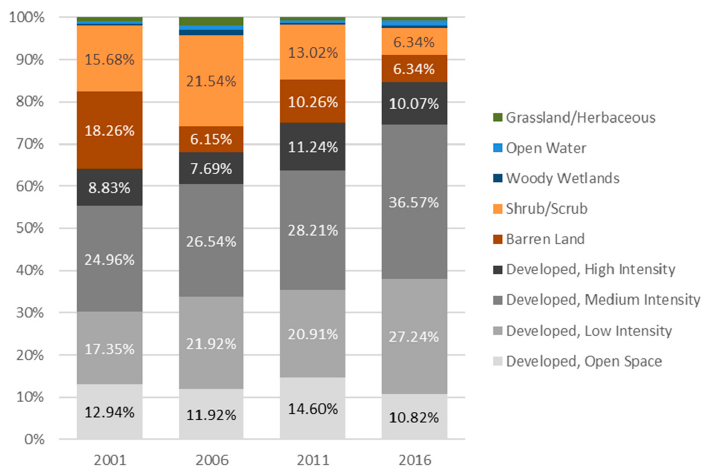
Figure 8. Percentage of each LULC type in urban heat sink areas.